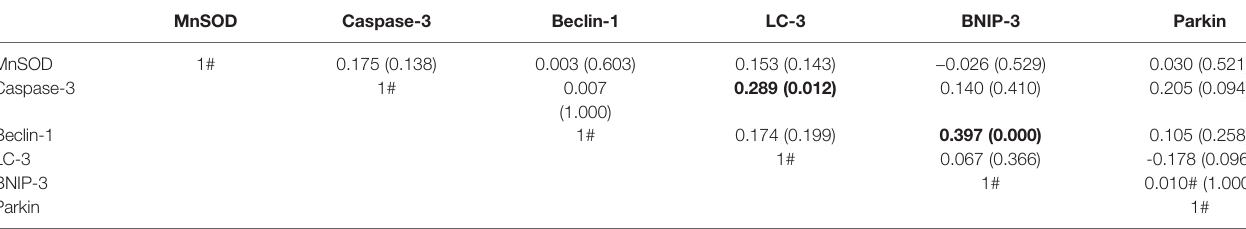
# indicates phi contingency coef fi cient value. p-values are showed in parenthesis. p < 0.05 were highlighted in